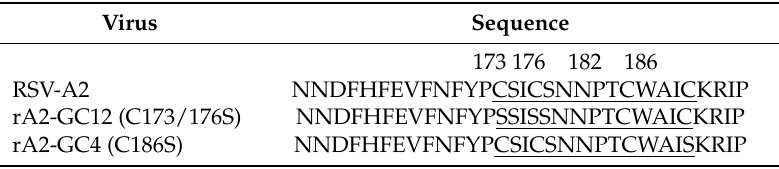
Table 1. Sequences of the conserved central region of RSV G